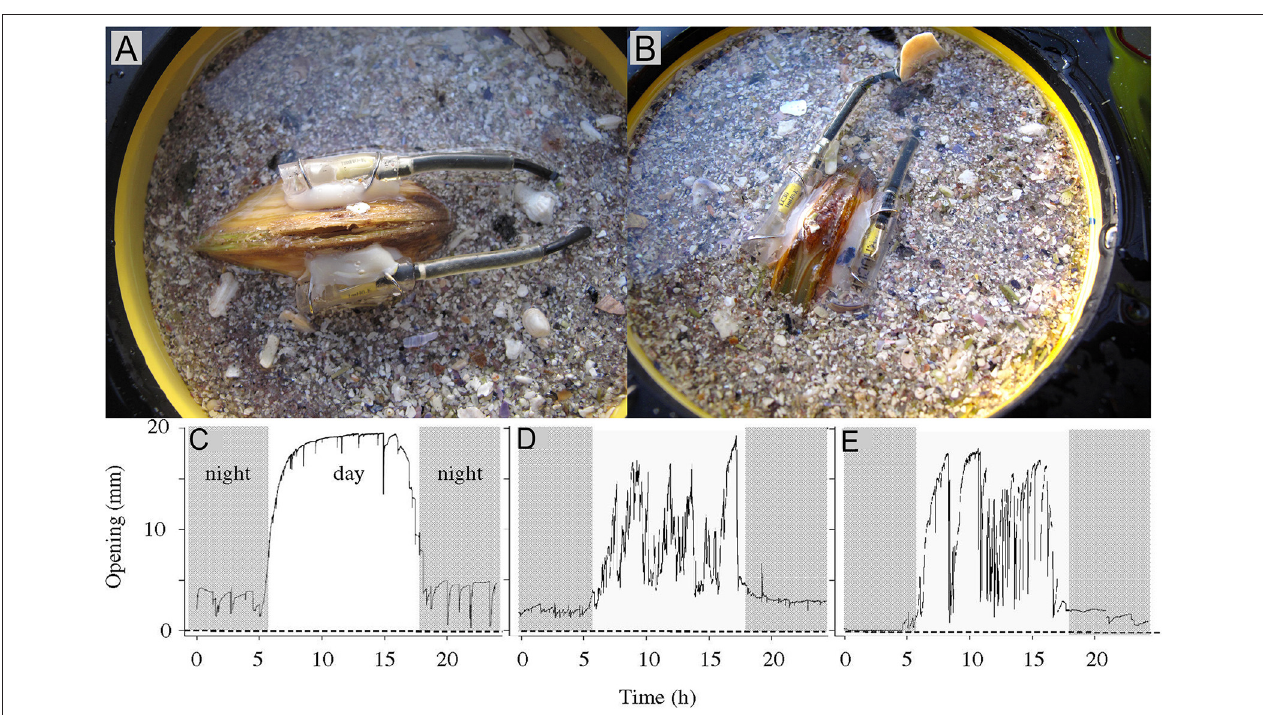
FIGURE 10 | Illustration of the principle of a valve position monitor. Photo attached electric sensors to monitor the valve position on a living specimen of A. islandica with (A) closed valves and (B) open valves. Schwartzmann et al. (2011) recorded typical disturbed daily valve behaviors in giant clams Hippopus hippopus. (C) Typical daily valve behavior in a resting giant clam. (D) Clam during the swell associated with Cyclone Gene (31 January 2008). (E) Clam after 3 weeks at temperatures ranging from 27 to 28 ◦ C (02 April 2008; sea surface temperature = 27.7 ◦ C) (Photo: Rob Witbaard, Figures C–E from Schwartzmann et al., 2011).